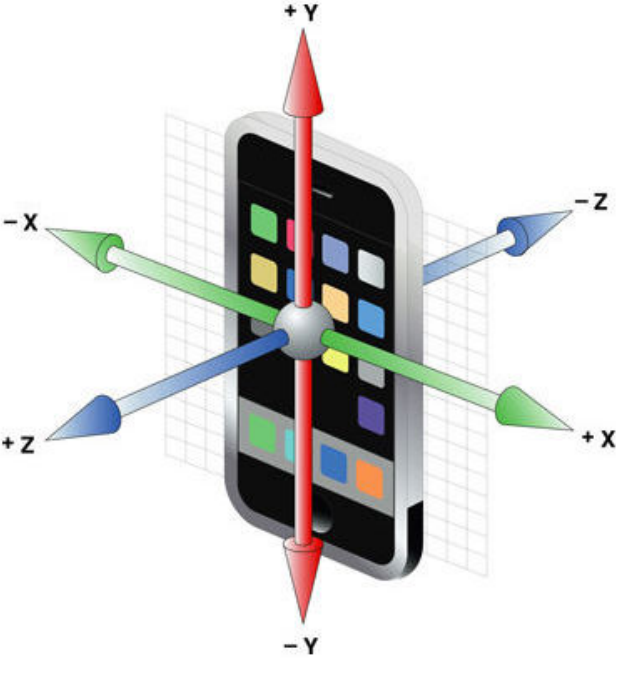
Figure 1. A 3D depiction of an iPhone’s triaxial coordinate system. Notice that both axis and direction are contingent on the phone’s orientation during movement.